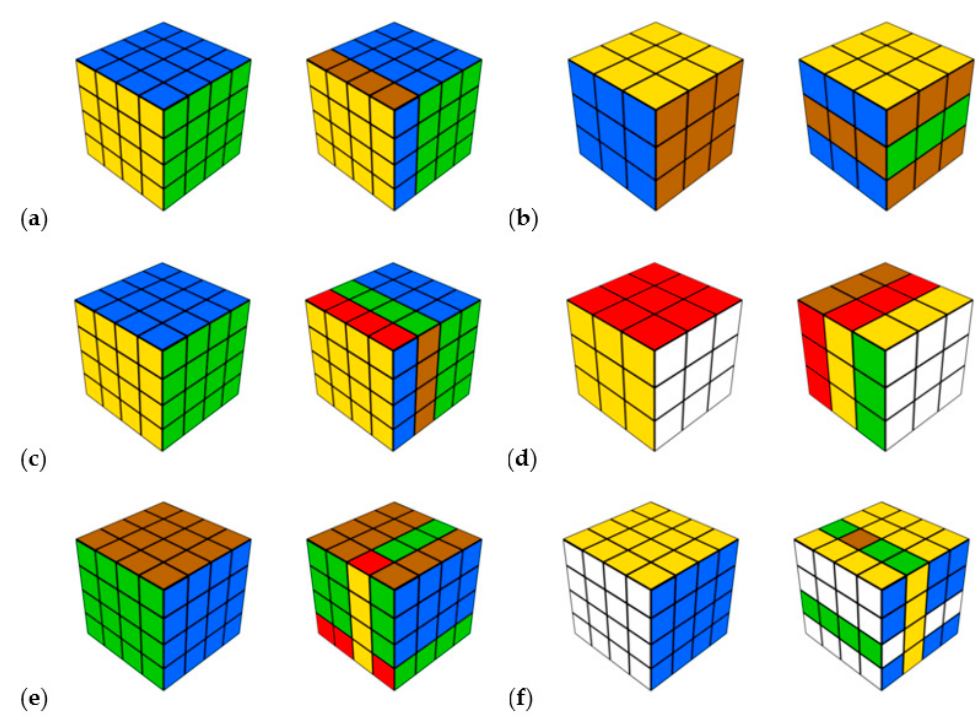
Figure 1. Possible items of the R-Cube-Vis Test for each di ffi culty level, ordered from easy ( a ) to di ffi cult ( f ). The task is always to decide whether both cubes are equal, except for rotated elements. Cognitive processing perspective, systematic viewing pa tt ern. It is expected that participants will increasingly show a systematic viewing pa tt ern from the beginning to the end, according to explanation 2 (Hypothesis 5a). Akin to gaze fi xations on relevant item parts, participants with a higher ability will show more systematic viewing pa tt erns, especially in the most di ffi cult levels. However, according to Fehringer (2020b), the reversed result is expected for the medium levels (Hypothesis 5b). The tasks in the medium levels demand more gaze switching between the two presented cubes than in the other di ffi culty levels (Figure 1, in Materials). In the two easiest and two most di ffi cult levels, the original version of the cube (left cube) can be easily derived from the right cube. In both medium levels, the original version is harder to detect.